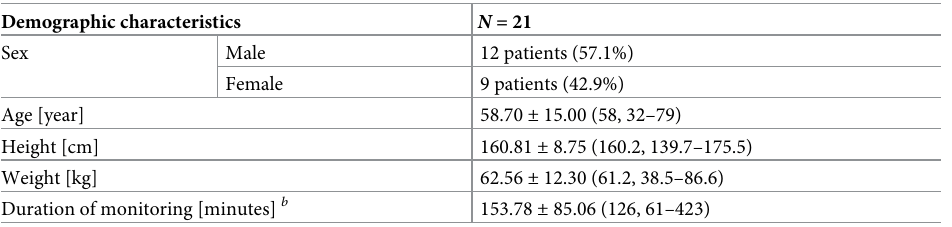
Table 1. Patients’ characteristics a